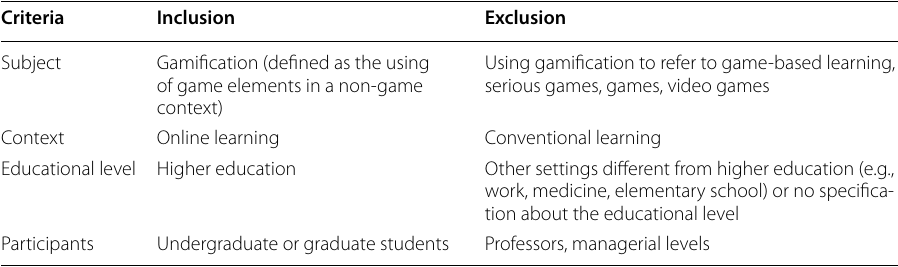
Table 1 Inclusion and exclusion criteria